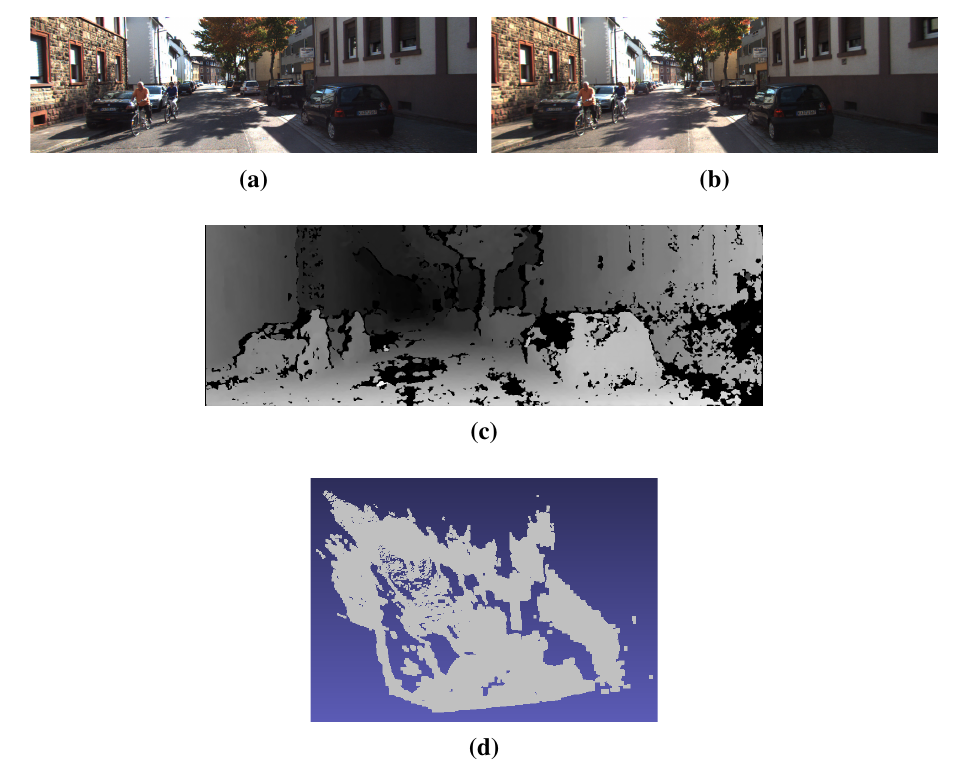
Figure 2. 3D reconstruction of a sample urban scene from KITTI. ( a ) Left camera image; ( b ) right camera image; ( c ) disparity map; ( d ) 3D point cloud.